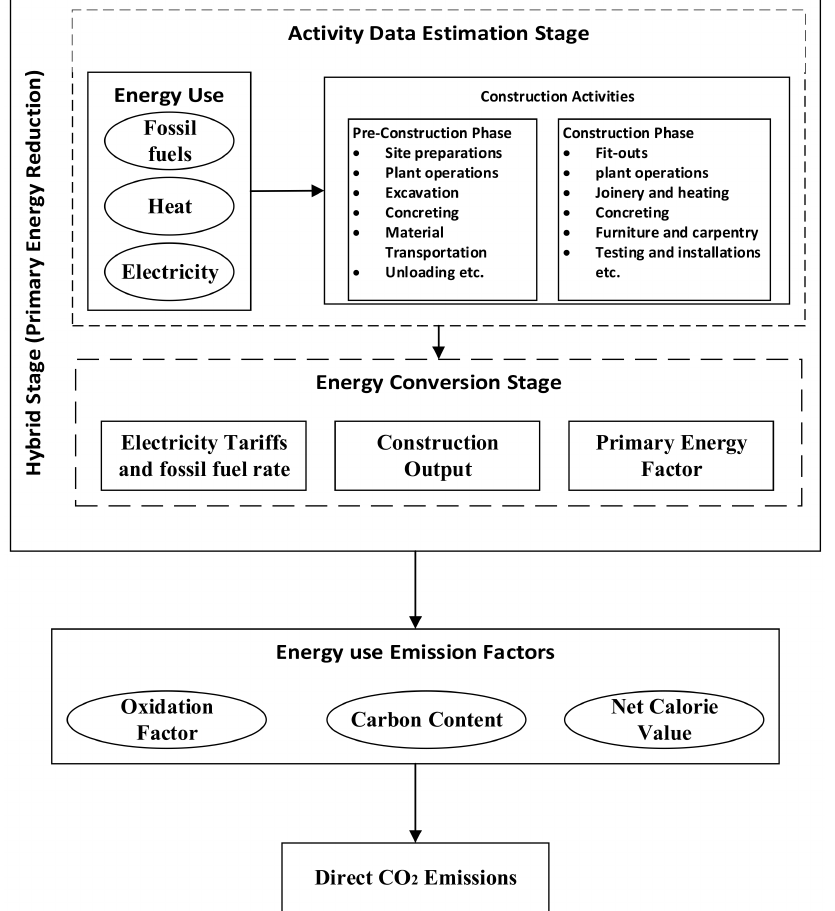
Figure 1. Hybrid quantification of CO 2 emission in China’s construction sector process